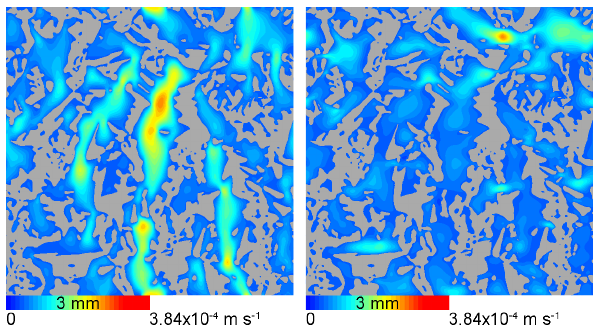
Fig.2. Verticalcrosssection(plane(y,z))ofanevolvedDHsample.Thecolorlevelsoftheimagescorrespond Fig. 2. Vertical cross section (plane (y,z)) of an evolved DH sam- to the fluid velocity (intensity) computed for a pressure drop of 2x10 − 2 Pa along the z (left) and y (right) ple. The color levels of the images correspond to the fluid velocity direction, and for a dynamic viscosity of air of 1.8x10 − 5 Pa s − 1 . The ice matrix of the microstructure is representedingray.Thelengthofthecolorbarcorrespondsto3mm. (intensity) computed for a pressure drop of 2 × 10 − 2 Pa along the z (left) and y (right) direction, and for a dynamic viscosity of air of 1 . 8 × 10 − 5 Pas − 1 . The ice matrix of the microstructure is repre- sented in gray. The length of the color bar corresponds to 3mm.